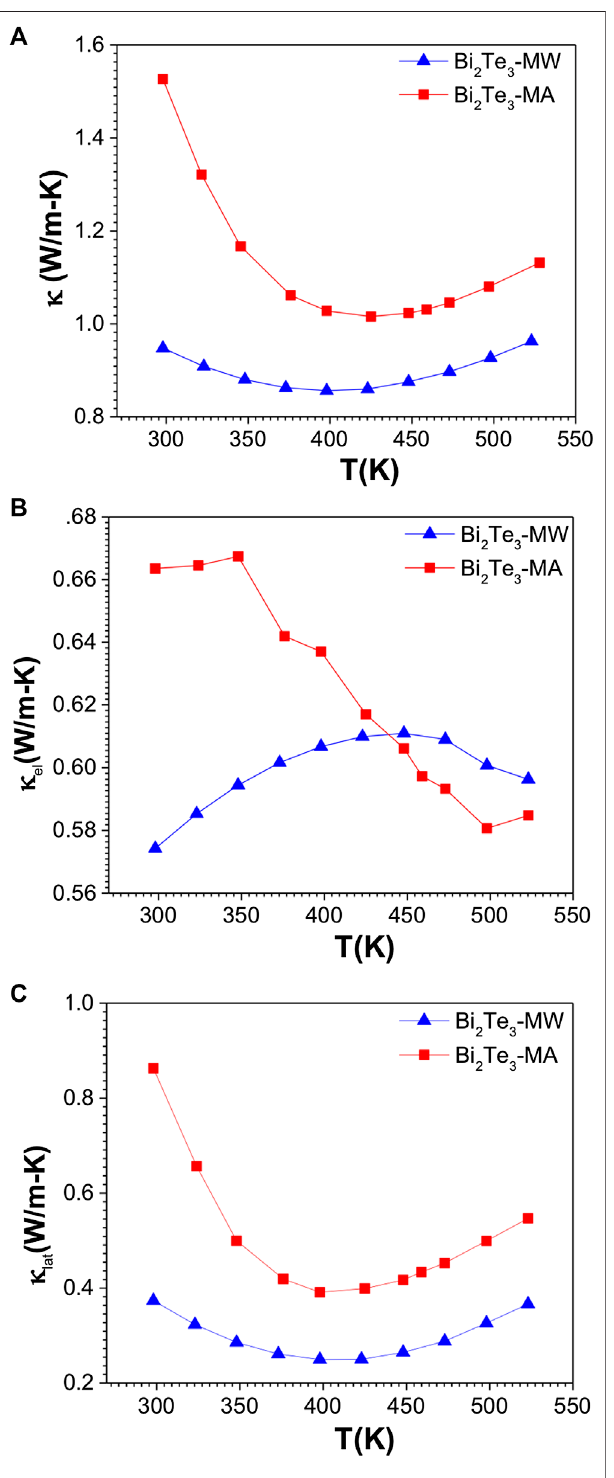
FIGURE6| Temperature-dependentthermalconductivityofSPsintered MA-Bi 2 Te 3 and MW-Bi 2 Te 3 samples: (A) total ( κ tot ), (B) electronic ( κ el ),and (C) lattice thermal conductivity ( κ lat ).